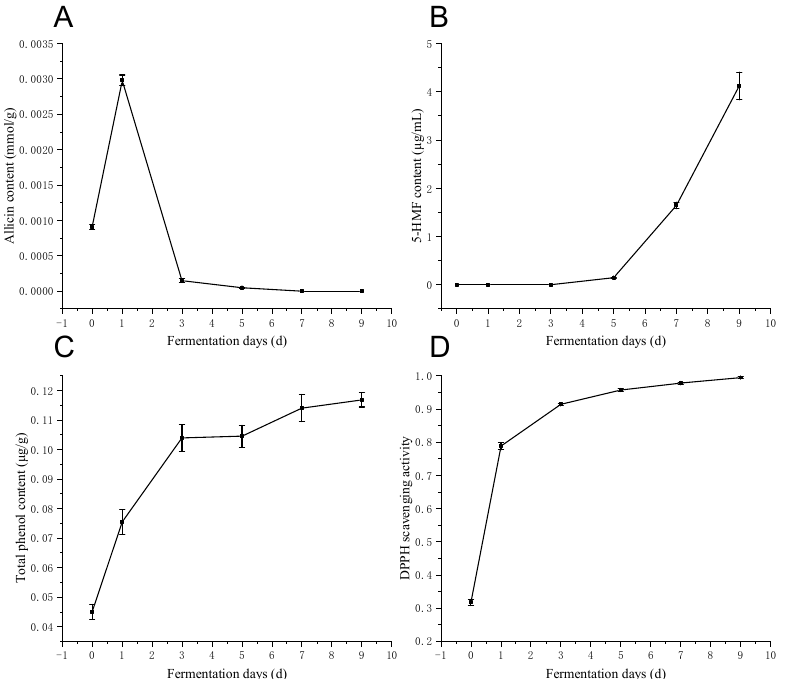
Figure 3. The change of allicin content ( A ), 5-HMF (5-Hydroxymethylfurfural) content ( B ), total phenols content ( C ), and antioxidant properties of black garlic (DPPH scavenging activity) ( D ) during the fermentation. All data were expressed as mean ± standard deviation (SD).